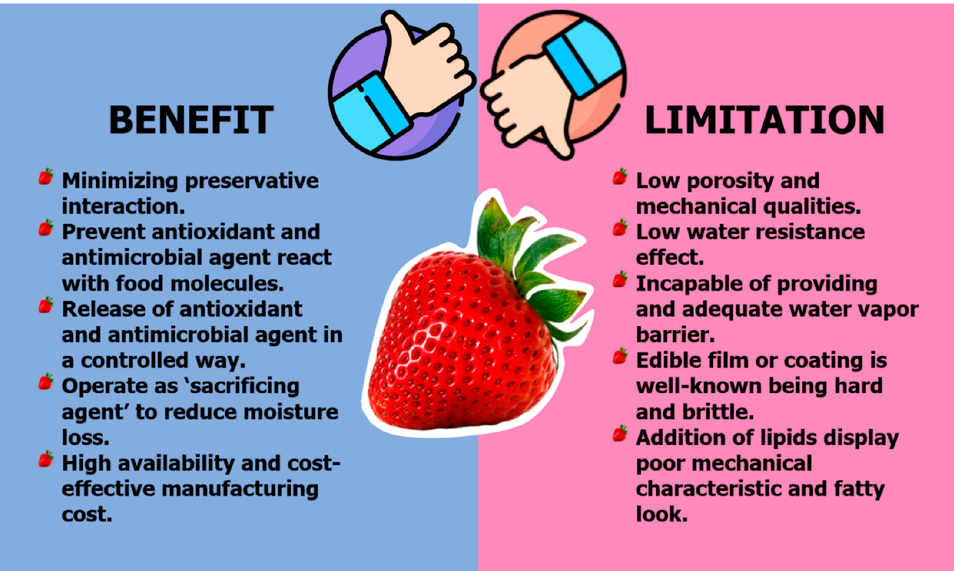
Figure 3. Summary of benefits and limitations of natural packaging.